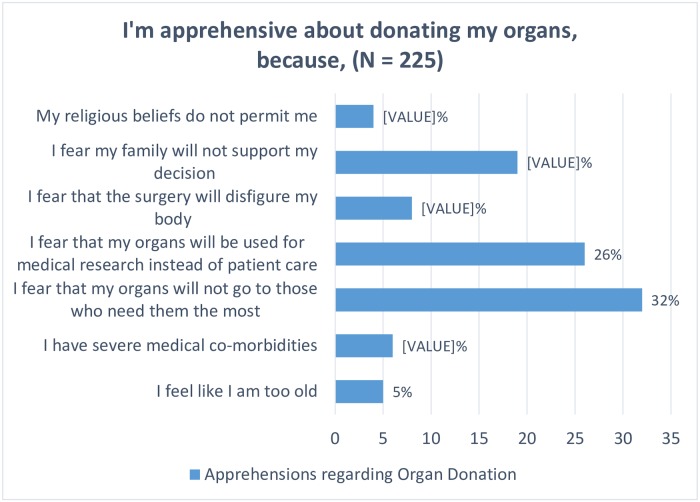
Bar-graph representing the apprehensions regarding organ donation.